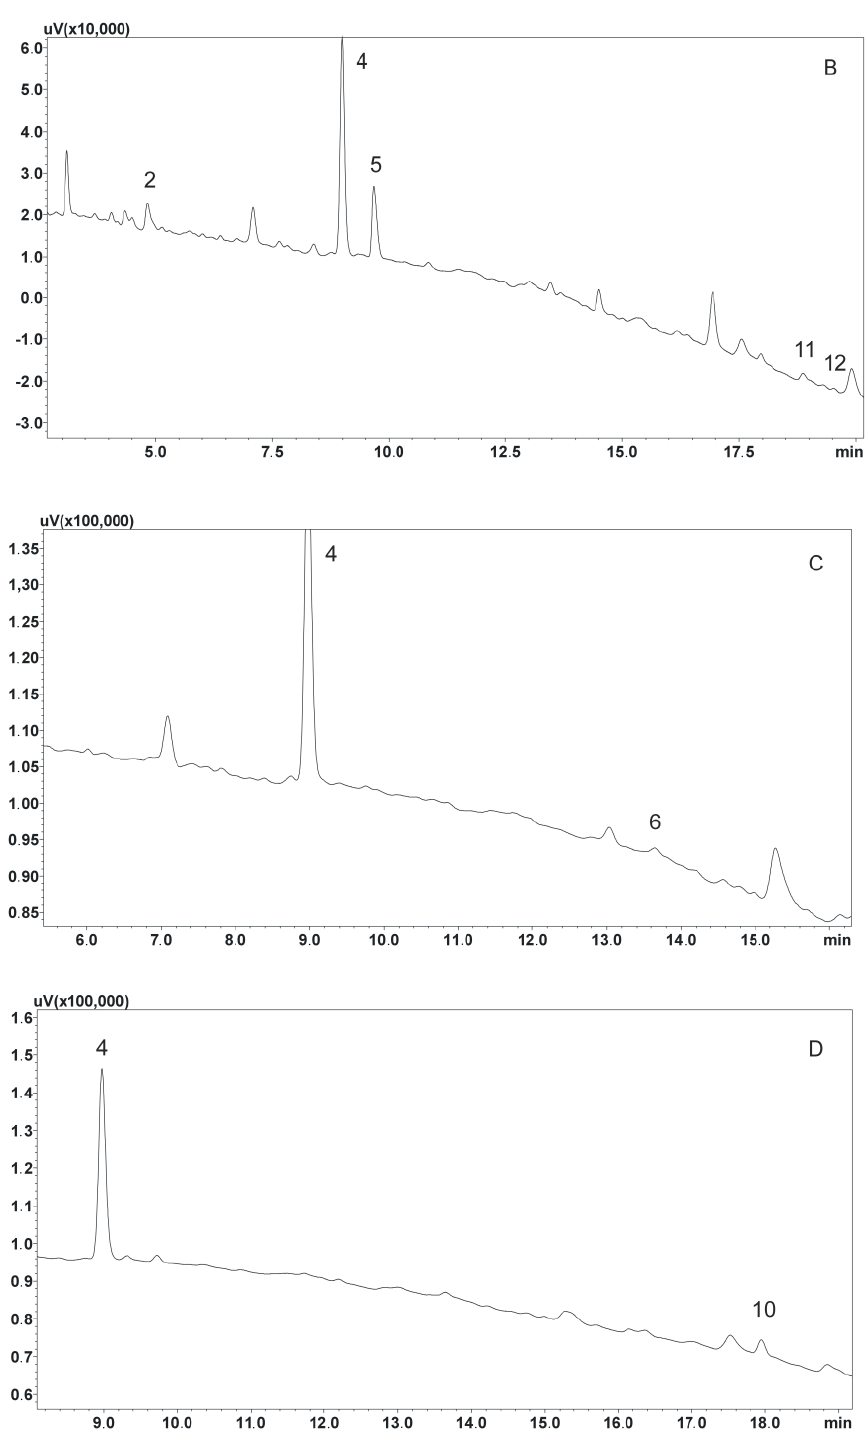
Figure 5. Chromatogram of saliva extracts of patients treated with studied compounds: ( A ) ven- lafaxine and mianserin, patient 8 (47 years); ( B ) venlafaxine and sertraline, patient 10 (57 years); ( C ) mianserin, patient 4 (28 years); ( D ) amitriptyline, patient 13 (55 years). (1) N–desmethylmirtazapine; (2) O–desmethylvenlafaxine; (3) mirtazapine; (4) chlordiazepoxide, IS; (5) venlafaxine; (6) mi- anserin; (7) N–desmethylcitalopram; (8) citalopram; (9) duloxetine; (10) amitriptyline; (11) N– desmethylsertraline; (12) sertraline. Table 4. The concentrations of antidepressants and their metabolites in saliva samples (drug doses in mg/day used by the patients are given in the parentheses).